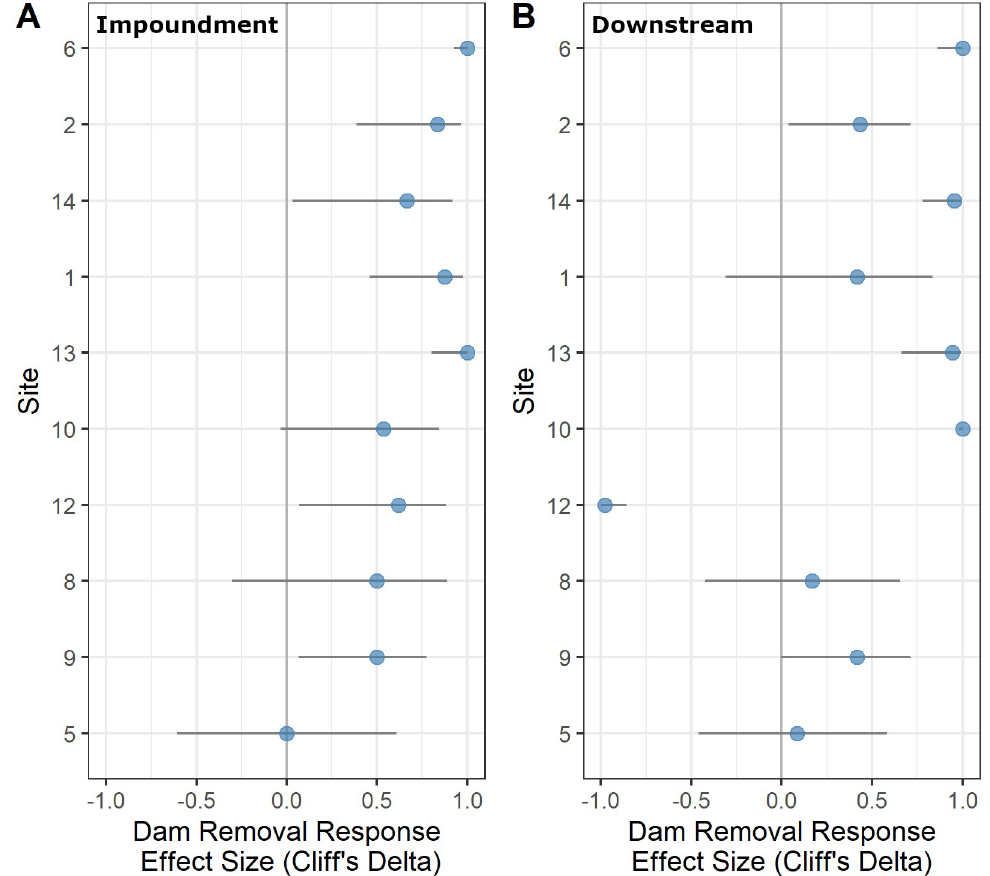
Fig 3. Magnitude and direction of Cliff’s delta effect size, which was used to assess the dam removal dissolved oxygen (DO) response in A) the impoundment, and B) downstream. Positive values indicate an increase in mean impoundment or downstream DO relative to upstream after dam removal. Gray bars indicate 95% confidence interval. Cliff’s delta values can be interpreted as negligible (| < 0.147|), small (| < 0.33|), medium (| < 0.474|) and large (|0.474–1.000|) effects. Sites are ordered from lowest (bottom) to highest (top) pre-removal impoundment